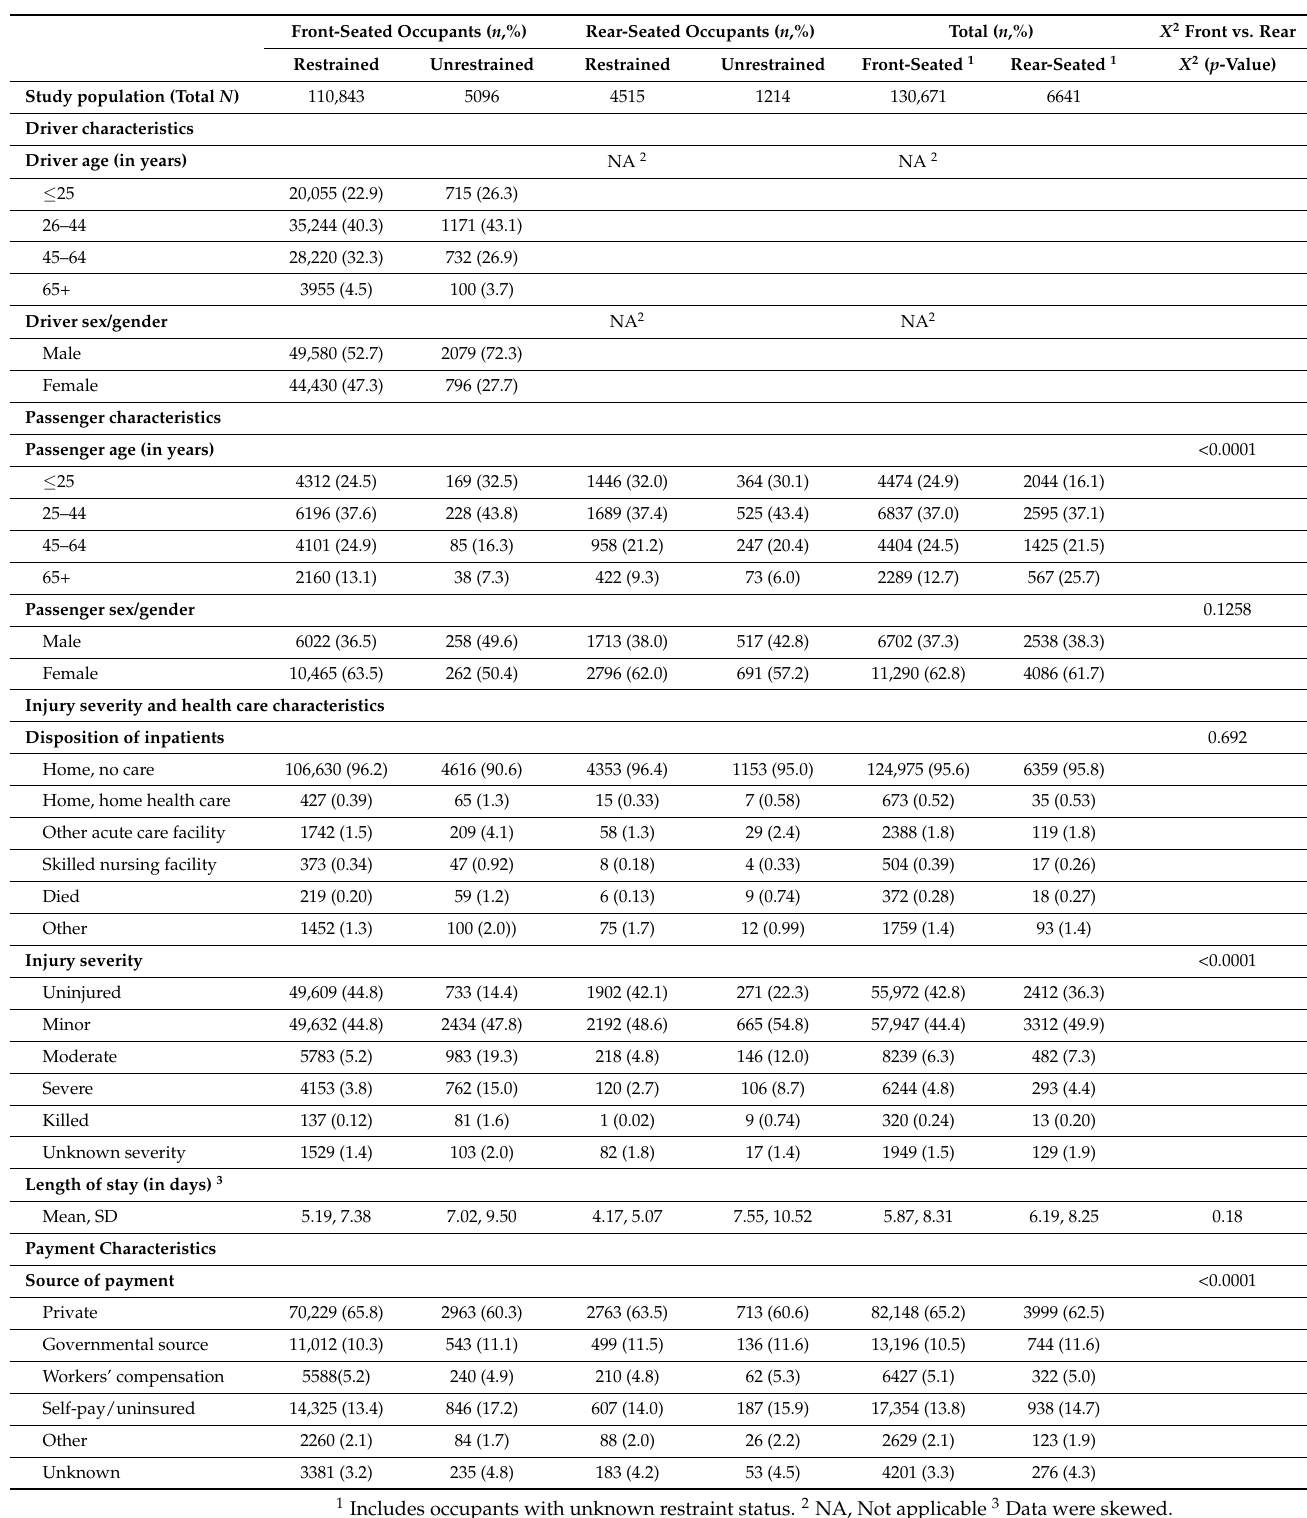
Table 1. Population Characteristics for Adult Occupants Involved in a Motor Vehicle Crash in New York State, Front-Seated and Rear-Seated Occupants by Restraint Status, Crash Outcome Data Evaluation System (CODES),